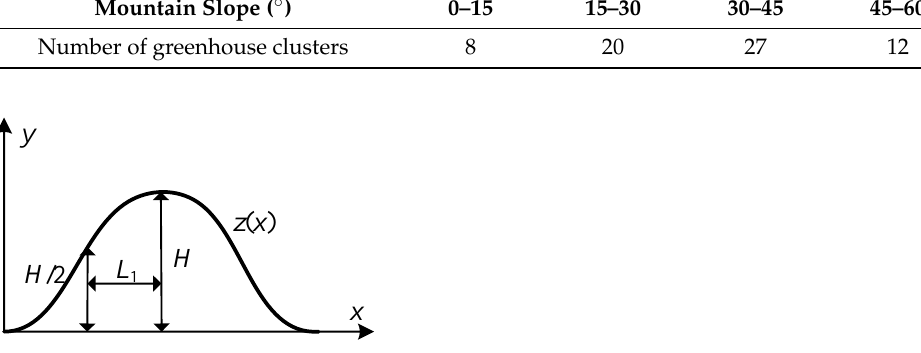
Figure 1. Parameter diagram of contour line equation of the sinusoidal model.